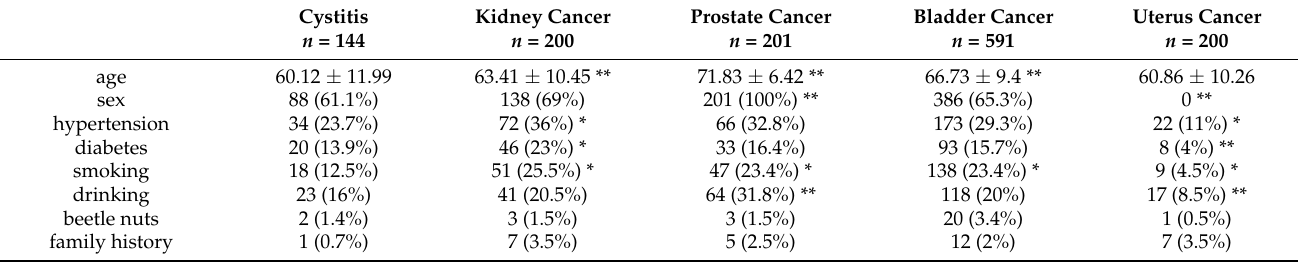
Table 4. Comparison of clinical characteristics and clinical laboratory data between patients with cystitis and patients with other